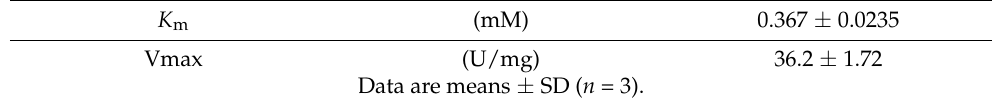
Figure 3. Optimal temperature and pH of purified FC rutinosidase. Optimal pH (A) of rutinosidase activity in homogenous purified using rutin as substrates was determined at different pHs: 2.0 (200 mM glycine - HCl buffer), 3.0 to 4.0 (200 mM citrate - LiOH buffer), 5.0 to 6.0 (200 mM acetate - LiOH buffer), 7.0 (200 mM imidazol - LiOH buffer), 8.0 (200 mM tris - HCl buffer), or 9.0 to 10.0 (200 mM borate - LiOH buffer). To assess optimal temperature (B), rutinosidase activity was measured at temperatures ranging 5–75° followed by 30 min pre-incubation of the enzyme solution. Data rep- resent the mean of independent experiments ( n = 3). Bars indicate SD. 3.3. Investigation of Rutin and Quercetin Concentration in FC Dough and Evaluation of Bitter- ness Rutin content in dough rapidly decreased after the addition of water and became almost zero after 10 min (Table 3). Parallel to the decrease in rutin, quercetin increased (Table 3). The decrease in rutin moles and increase in quercetin moles were almost the same, suggesting that increased quercetin was generated by rutinosidase activity. In the bitterness evaluation of flour, no panelists felt bitterness in common buckwheat, whereas all panelists reported strong bitterness in the FC flour. In addition, no panelists felt